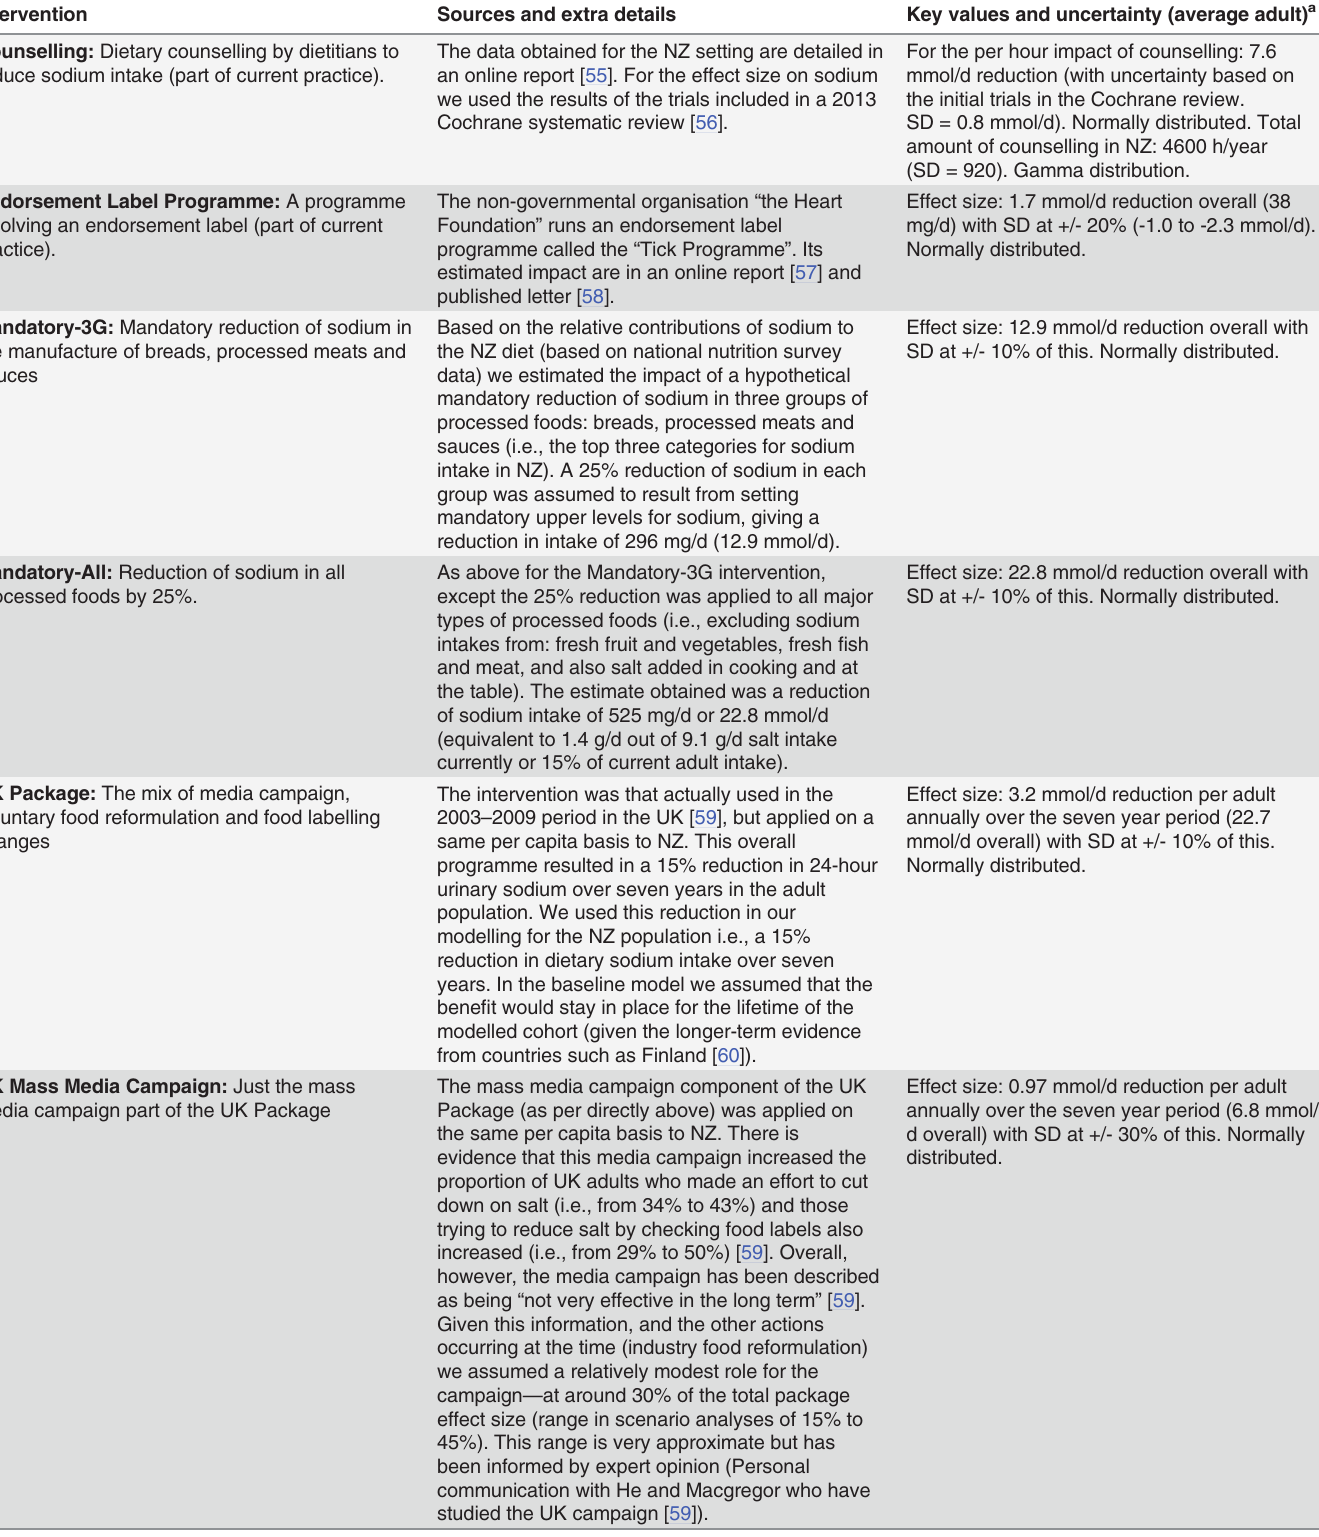
Table 2. Input parameters relating to the interventions effects (for further details see S1 File) Intervention Sources and extra details Key values and uncertainty (average adult)